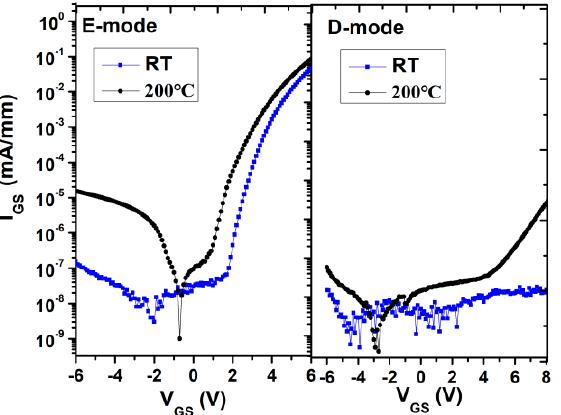
Figure 3. Direct current (DC) output and transfer characteristics for ( a ) E-mode GaN HEMT with L G /L GS /L GD = 1.8/1/5- µ m and ( b ) D-mode GaN HEMT with L G /L GS /L GD = 1.5/1/5- µ m.